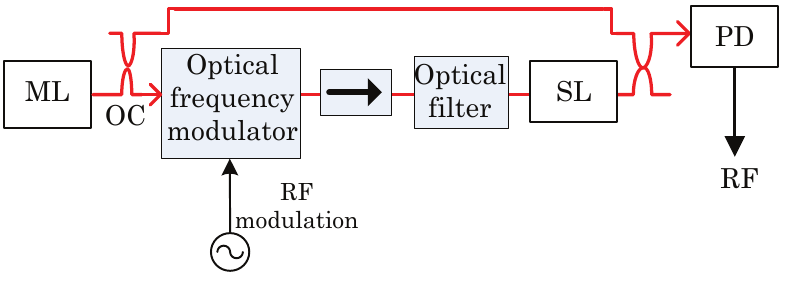
Figure 3. Schematic of side frequency injection locking. ML, master laser; OC, optical coupler; OFM, optical frequency modulator; SL, slave laser; PD,